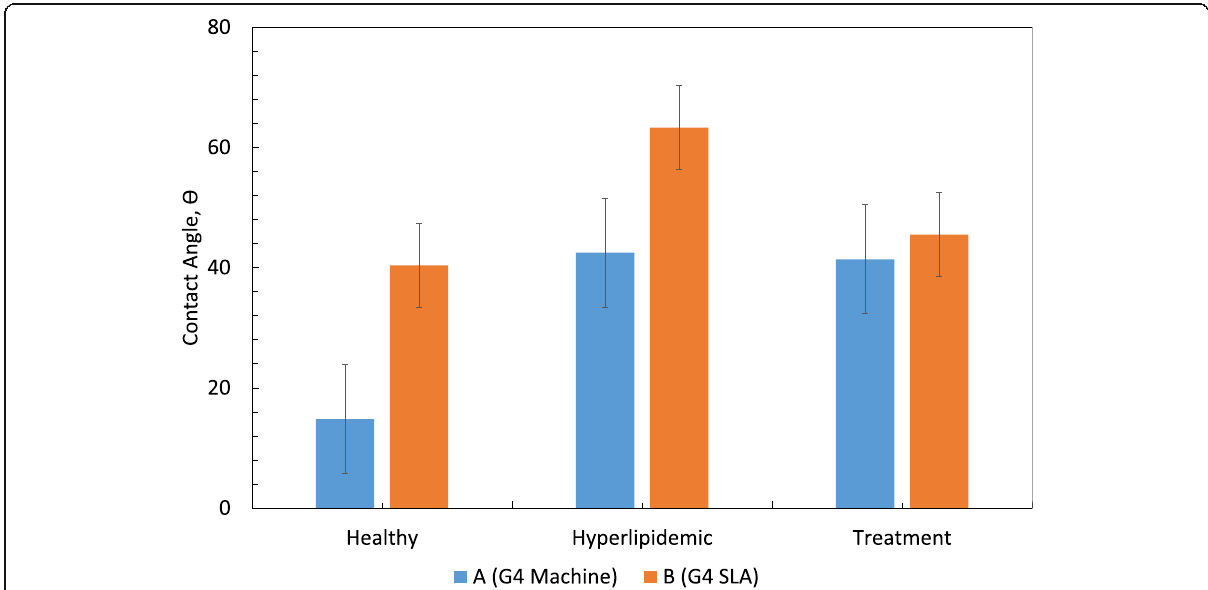
Fig. 6 Evaluation of the groups according to the period and double comparisons of group A and B, p value by